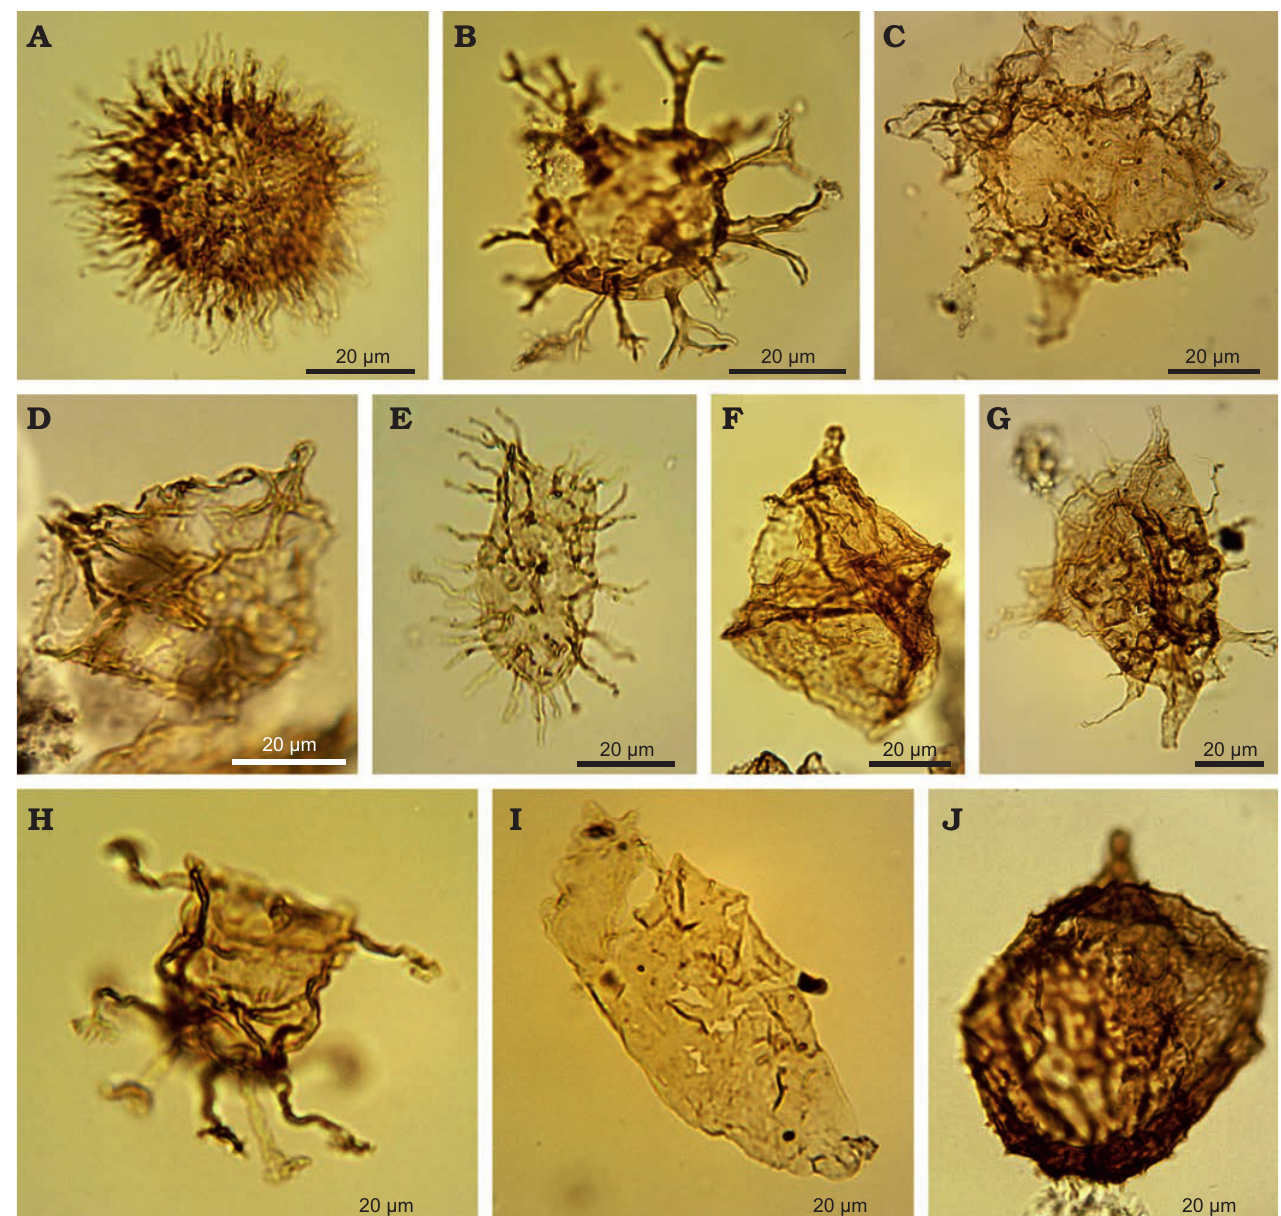
Fig. 6. The Lower Cretaceous organic­walled dinoflagellate cysts from the Kościeliska Marl Formation in the Lejowa Valley, Tatra Mountains, Poland. A . Cometodinium habibii Monteil, 1991. B . Cymososphaeridium validum Davey, 1982. C . Phoberocysta neocomica (Gocht, 1957) Millioud, 1969. D . Stanfordella ? cretacea (Neale and Sarjeant, 1962) Helenes and Lucas­Clark, 1997. E . Prolixosphaeridium sp.. F . Endoscrinium campanula (Gocht, 1959) Vozzhennikova, 1967. G . Phoberocysta neocomica (Gocht, 1957) Millioud, 1969. H . Bourkidinium elegans Torricelli, 1997. I . Wallodinium krutzs ­ chii (Alberti, 1961) Habib, 1972. J . Cribroperidinium orthoceras (Eisenack, 1958). A–I sampled from ZPAL Am. 25/2; J sampled from ZPAL Am.